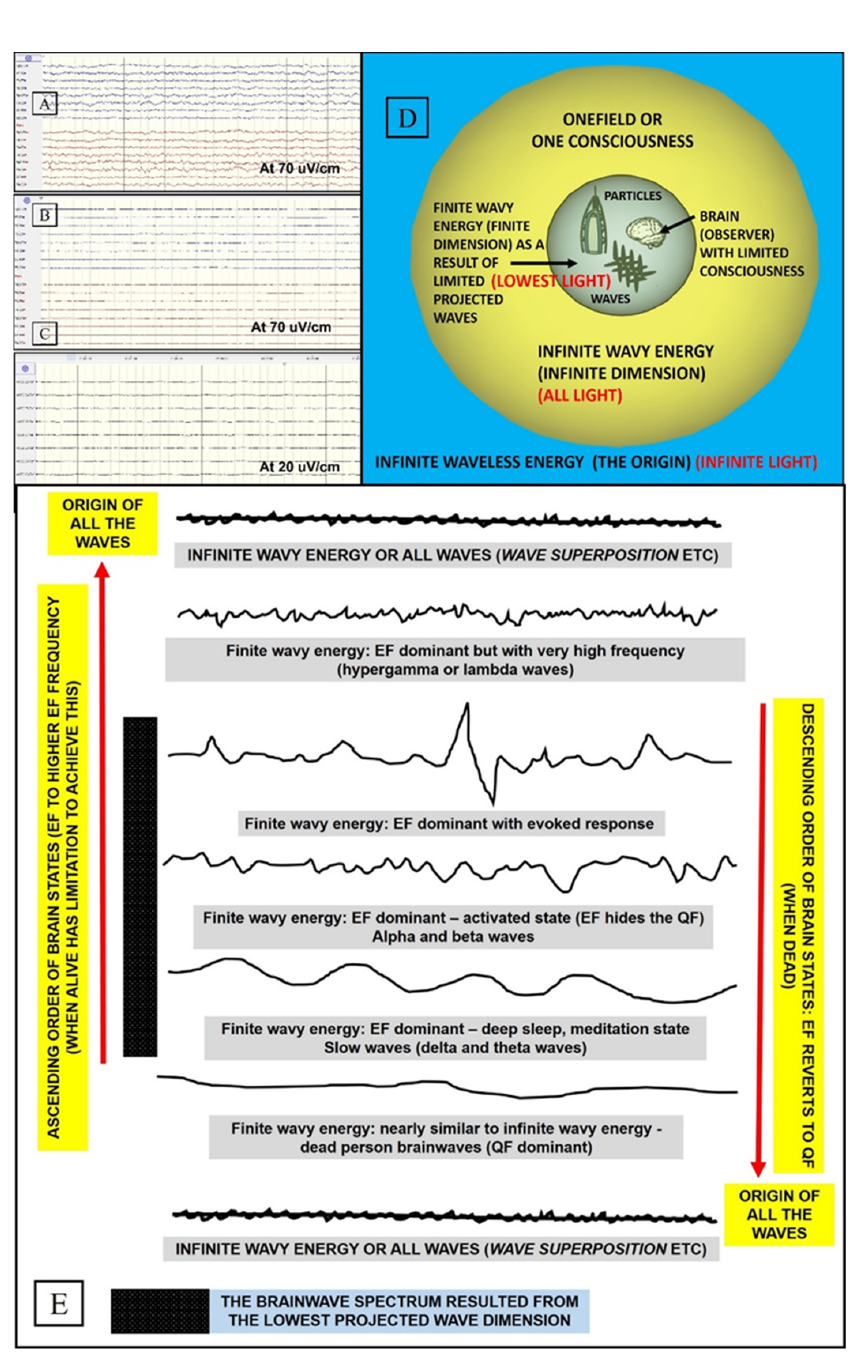
Figure 4. Electromagnetic field, quantum field, and the two ends of the spectrum. ( A ) Scalp electroencephalography (EEG) brainwaves of a healthy person with wavy feature. ( B ) Scalp EEG brainwaves of a dead person at the same sensitivity (70 uV/cm), which now appear isoelectric (flattened). ( C ) Wavy background section of a dead person’s brainwaves recorded directly on the brain surface and viewed at the highest scale (electrocorticography or ECoG at 20 uV/cm). ( D ) The relationship among infinite waveless energy (infinite light), infinite wavy energy (all light/first created light), and finite wavy energy (lowest light). ( E ) The descending order of brainwaves, from electromagnetic field (EF)-dominant to brain quantum field-dominant (dead person), and the ascending order of brainwaves, to the highest EF frequency (hypergamma and lambda) (alive person), may also come closer to infinite wavy energy, oneness, or one consciousness (heightened state of consciousness).